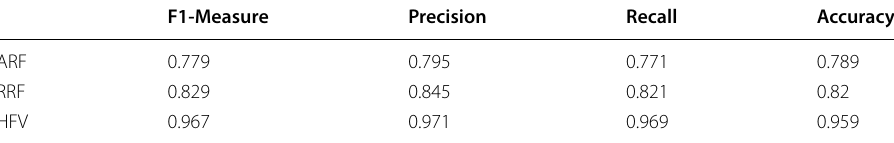
Table 2 Comparison of proposed features extraction methodologies using